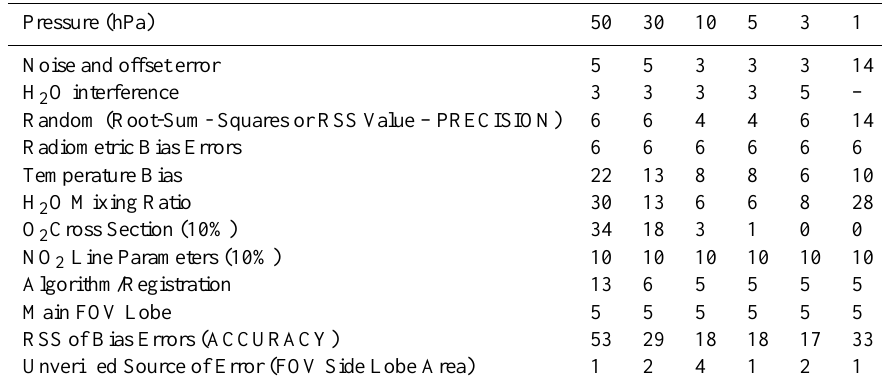
5% in the middle stratosphere, to 8% for nighttime or 30% for daytime at 1 hPa, and then to 15–20% at 40 hPa. The es- timated SD values in Fig. 5 agree with the RSS precisions in Table 2 for the middle and upper stratosphere but are larger at 30 and 50 hPa, presumably because of the effects of the natural variability of the atmospheric NO 2 , H 2 O, and tem- perature. A linear scaling was applied to the entries of the V5 NO 2 error table in Russell et al. (1984a) for its V6 bias errors, based on a model-generated, daytime profile at 32 ◦ N. Its pri- mary sources of systematic uncertainty are from temperature bias and from the interfering effects of H 2 O, based on the V6 uncertainties in Remsberg et al. (2004) and Remsberg et al. (2009), respectively. There are uncertainties in the lower stratosphere due to the O 2 interference, but they should be considered as an upper limit because corrections for the O 2 emission were applied to the retrievals of both the LIMS H 2 O and NO 2 and therefore carry the same sign. There is also a possible bias due to a 20% uncertainty for the area of the measured FOV side lobes; its effect on the retrieved NO 2 is believed to be small but remains unverified. Table 2 indicates RSS V6 NO 2 uncertainties of 17% at 3 hPa and about 18% from 5 to 10 hPa. RSS values